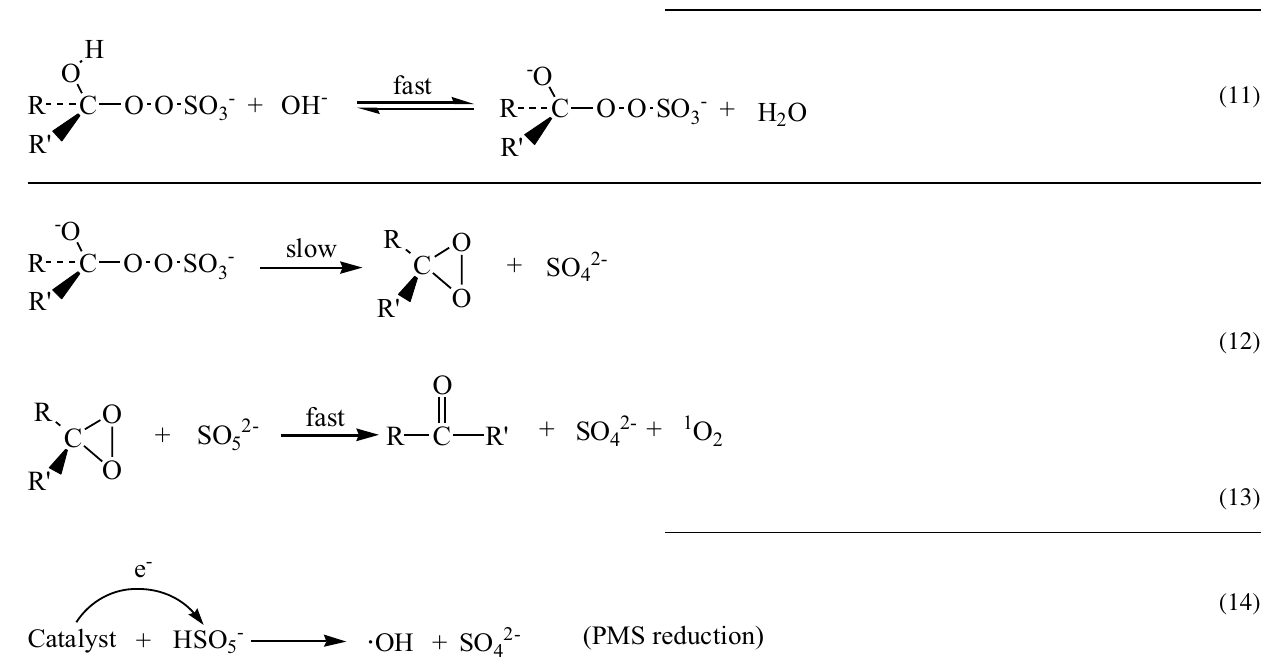
50 /g-C 3 N 4 , used WPBC 50 /g-C 3 N 4 and g-C 3 N 4 : a survey spectra, b C 1